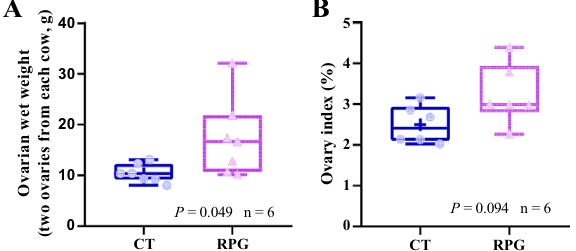
Figure 1. Box and whisker plots of the ovarian weight ( A ) and ovary index ( B ) from postpartum dairy cows that show significant ( P < 0.05) or a tendency (0.05 < P < 0.01) between the control diet and the rumen-protected glucose